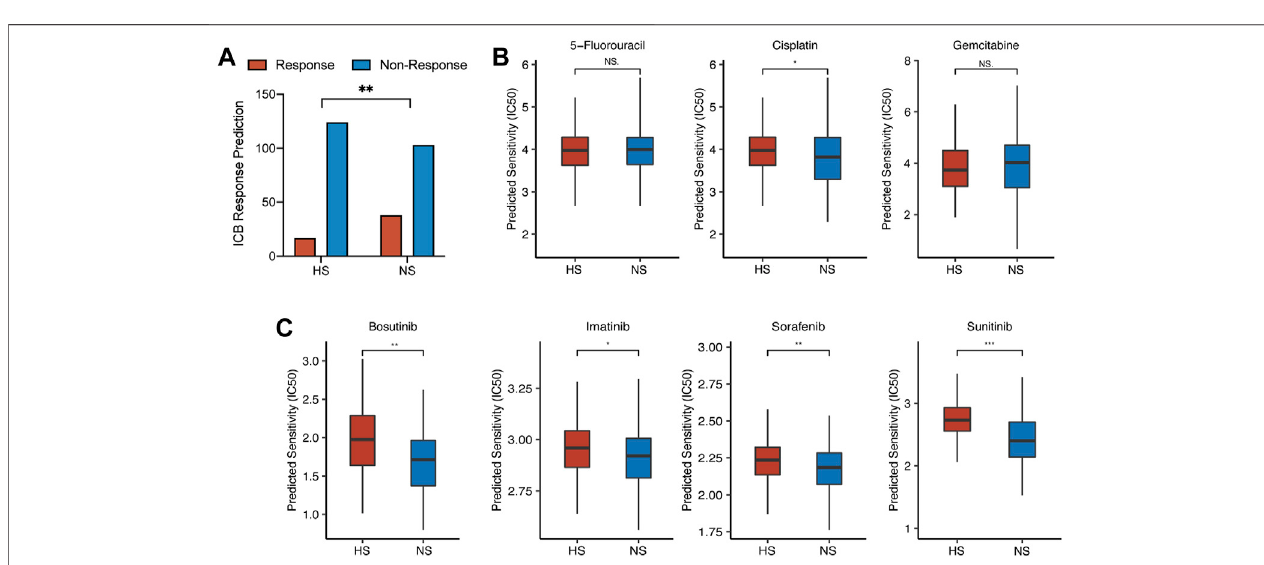
FIGURE 8 | The differences in drug response between NS and HS. (A) ICB response prediction showed that the number of patients sensitive to ICB therapy was larger in NS than that in HS (38 in NS vs. 17 in HS). (B) The results of cytotoxic therapy response prediction revealed that the IC50s of these drugs were comparable between the two subgroups. (C) The IC50s of targeted medicine, including bosutinib, imatinib, sorafenib, and sunitinib, were lower in NS, compared with those in